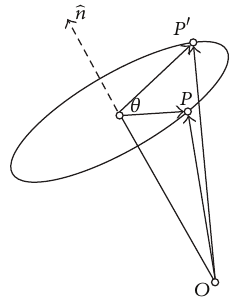
Figure 5: Rotating a point about an arbitrary axis